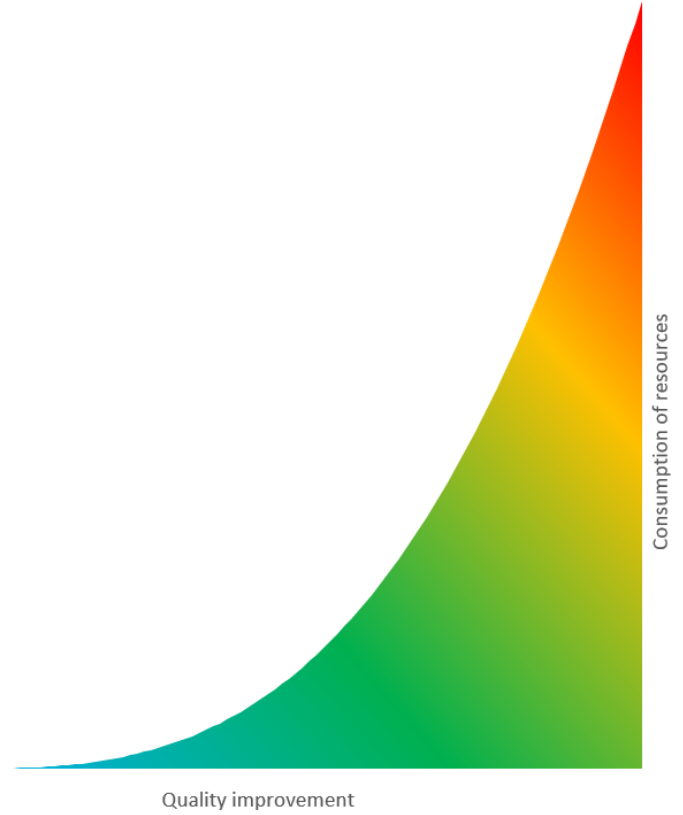
Figure 1. Consumption of resources for quality improvement (the authors’ own study).